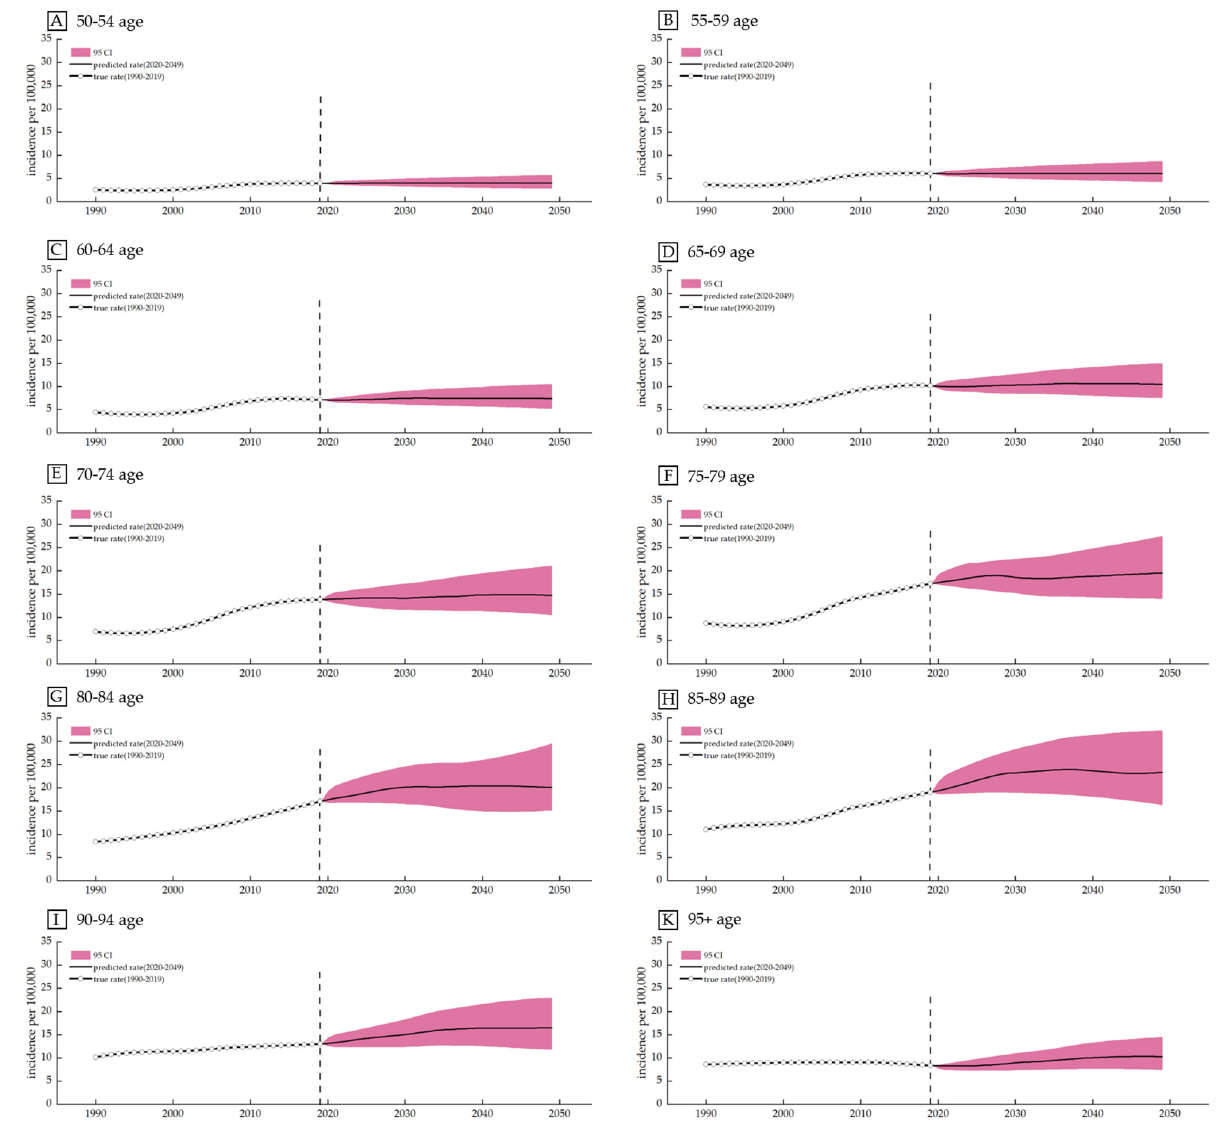
Figure 6. Prediction of lip and oral cavity cancer incidence among females and males in China from 2020 to 2049 based on the Bayesian APC model.